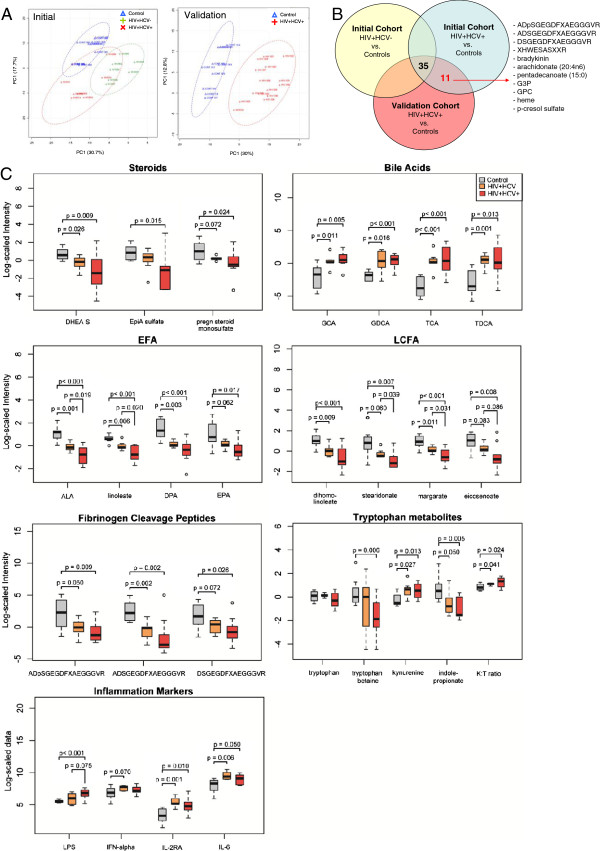
Metabolic pathways altered in HIV+HCV- and HIV+HCV+ subjects on PI-based ART. (A) PCA analysis shows separation of control (blue), HIV+HCV- (green), and HIV+HCV+ (red) metabolomes (n=227 metabolites) in initial and validation cohorts. (B) Venn diagram showing the distribution of metabolites altered in HIV+HCV+ subjects in initial and validation cohorts (n=46; FC>1.3, p<0.05, FDR<10%). (C) Box plots of metabolite classes altered in HIV+HCV- (n=7) or HIV+HCV+ (n=10) subjects compared to controls (n=8) matched for age, gender, and race/ethnicity. Medians are represented by horizontal bars, boxes span the interquartile range (IQR) and whiskers extend to extreme data points within 1.5 times IQR. Outliers plotted as open circles lie outside 1.5 times the IQR. Grey, orange, and red box plots represent controls, HIV+HCV- and HIV+HCV+ subjects, respectively. P-values were calculated using Welch’s t-tests. K:T ratio; kynurenine to tryptophan ratio.